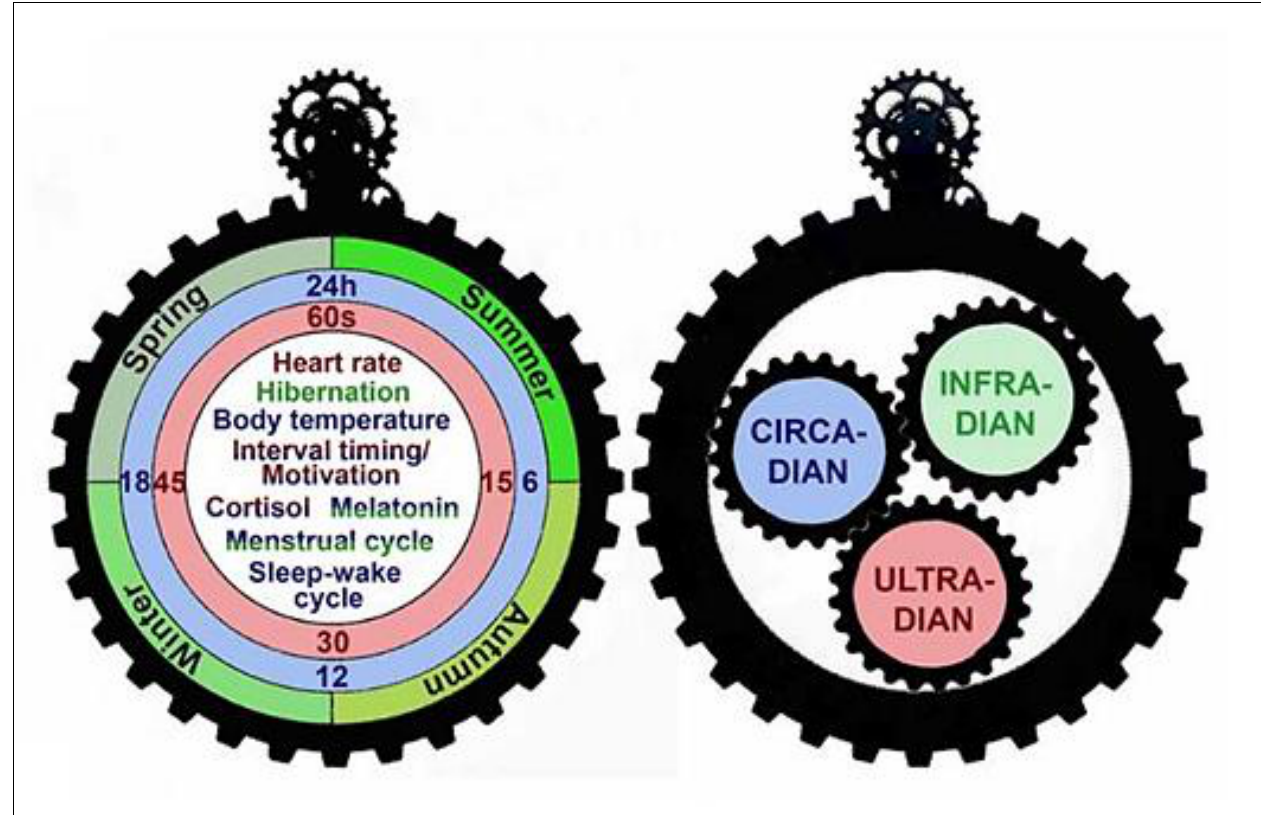
Figure 4. Some metabolic and physiological activities under the influence of ultradian, circadian, and infradian rhythms; reprinted from Ref. [85]. Some analytes and physiological events are under the influence of more than one variation. For example, cortisol secretion has both circadian and ultradian rhythms and the menstrual cycle has infradian and circadian rhythms.